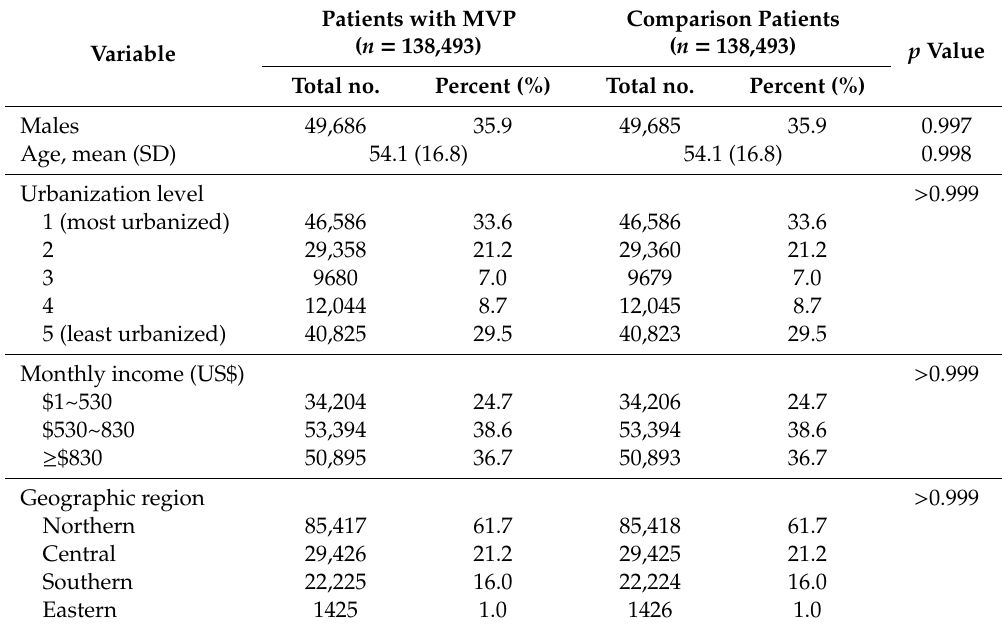
Table 1. Demographic characteristics of patients with mitral valve prolapse (MVP) and comparison patients ( n =